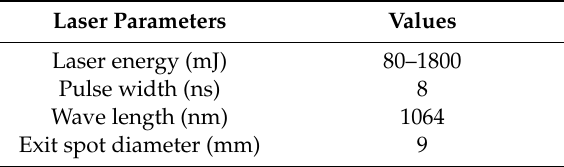
Figure 3. Process of laser dynamic flexible micropunching with LPS. ( a ) Before LPS; ( b ) After LPS; ( c ) Before laser dynamic flexible micropunching; ( d ) After laser dynamic flexible micropunching. Table 2. Main parameters of the Spitlight2000, an Nd: YAG Table 1. Detailed experimental parameters.